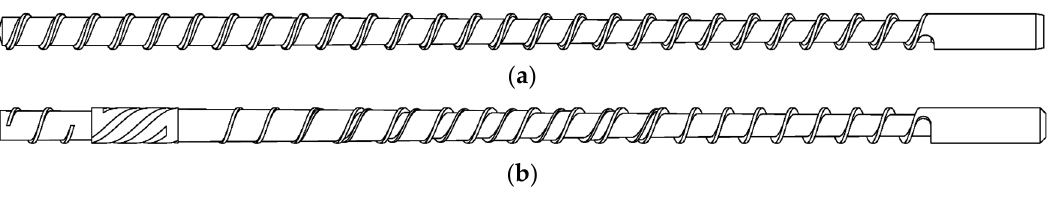
Figure 2. Depiction of two plasticating screws: ( a ) General purpose, square‐pitched screw; ( b ) Barrier screw with melt channel, barrier flight, and mixing element. Table 1. Screw design parameters.